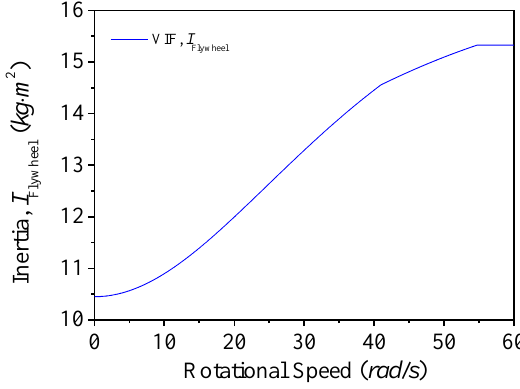
Figure 16. Inertial variation for the flywheel.